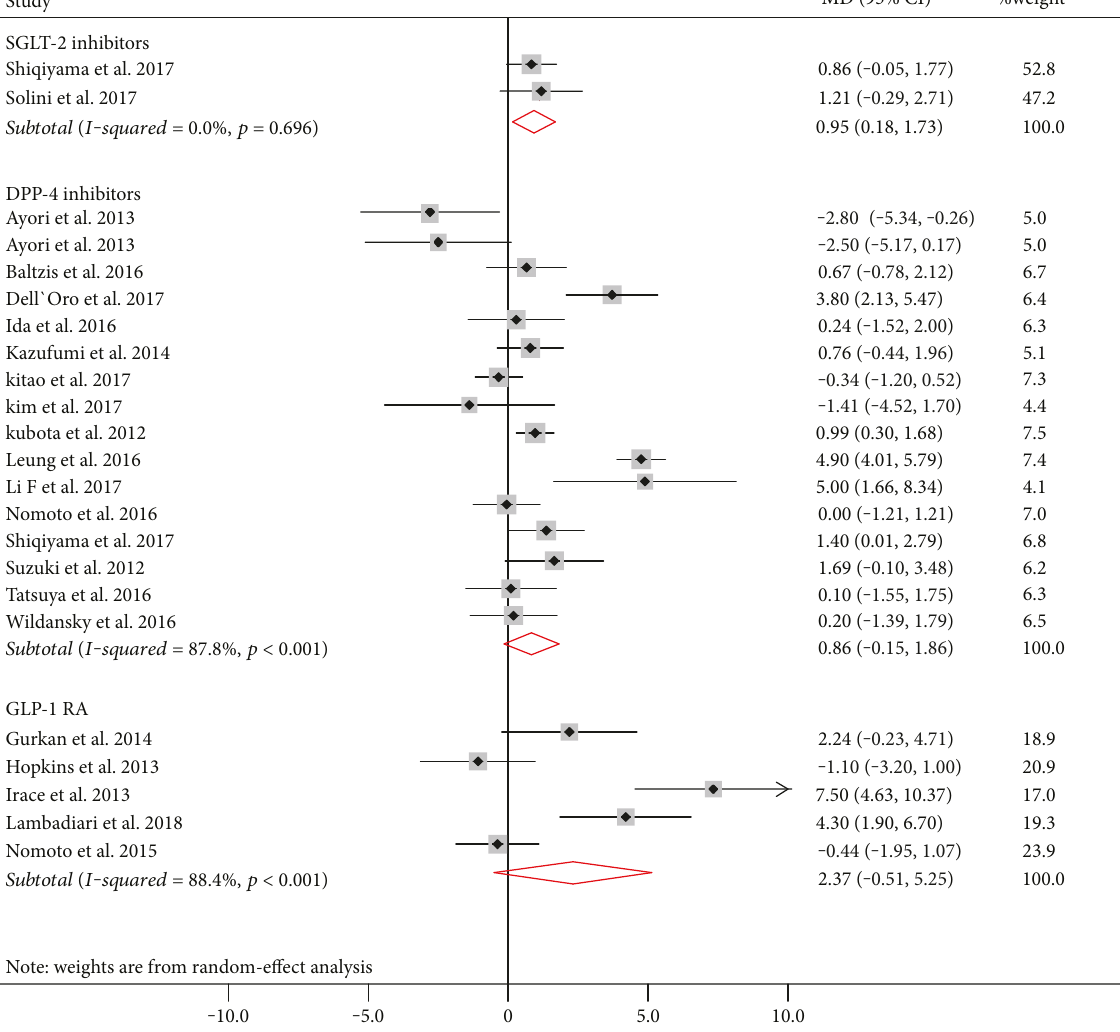
Figure 2: E ff ects of newer antidiabetic drugs on endothelial function. Squares indicate the mean di ff erence (MD) and the respective 95% con fi dence intervals in fl ow-mediated dilatation (FMD) before/after treatment from eligible studies. The size of the squares corresponds to the weight of each study. The diamonds and their width represent the pooled MD and the 95% CI, respectively. DPP-4 =DPP-4 inhibitors, SGLT-2 inhibitors, and GLP-1 RAs and de fi nes them under the fi gure. DPP-4: dipeptidyl peptidase-4; GLP-1 RAs: glucagon- like peptide-1 receptor agonists; SGLT-2: sodium-glucose